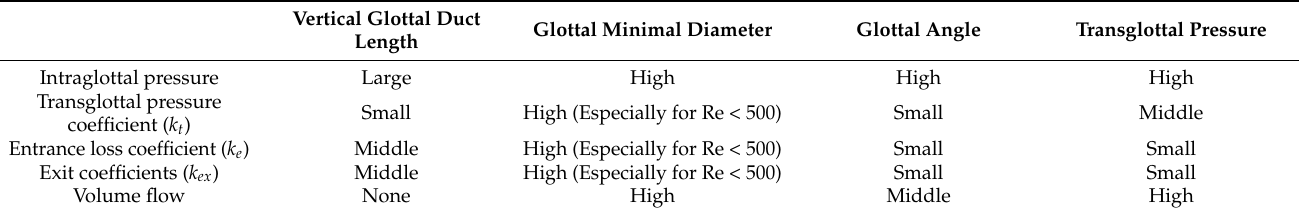
Table 3. The effects of vocal fold physiological parameters on intraglottal aerodynamic parameters for convergent glottal